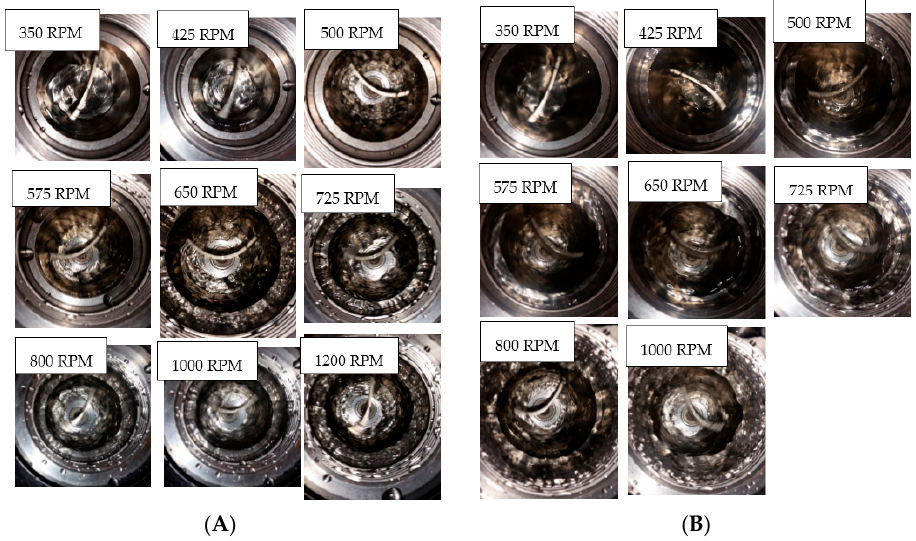
Figure 10. Flow pattern at ( A ) 50 mL and ( B ) 100 mL water in a 141.4 mL cell.